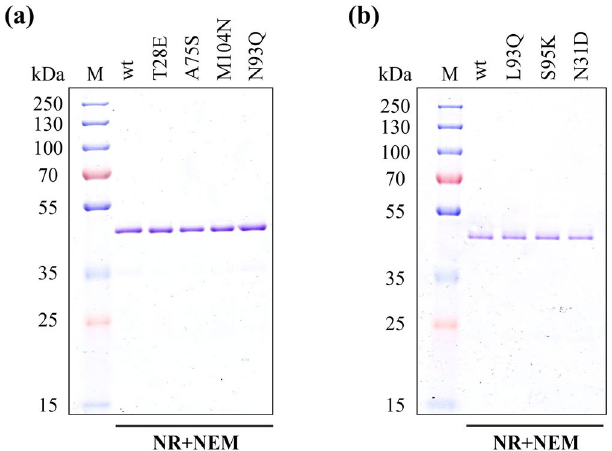
Figure 5. SDS-PAGE analysis of purified wild type Fabs and their variants under non-reducing (NR), NEM treated conditions ( a ). REGN10933 Fab wild type (wt) and variants ( b ). REGN10987 Fab wild type (wt) and variants (M: Protein Marker). See Supplementary Fig. S3 for the uncropped gel image.